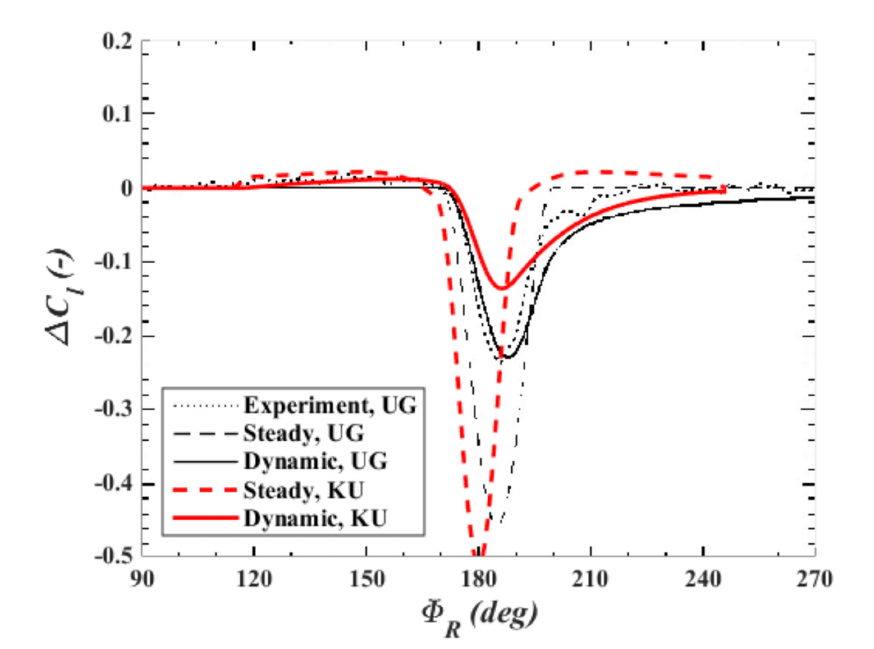
Figure 10. Deviations in the lift coe ffi cient at blade η B = 75% according to the present method with the present threshold, C d = 0.6, V T = 36.0 m / s [24].